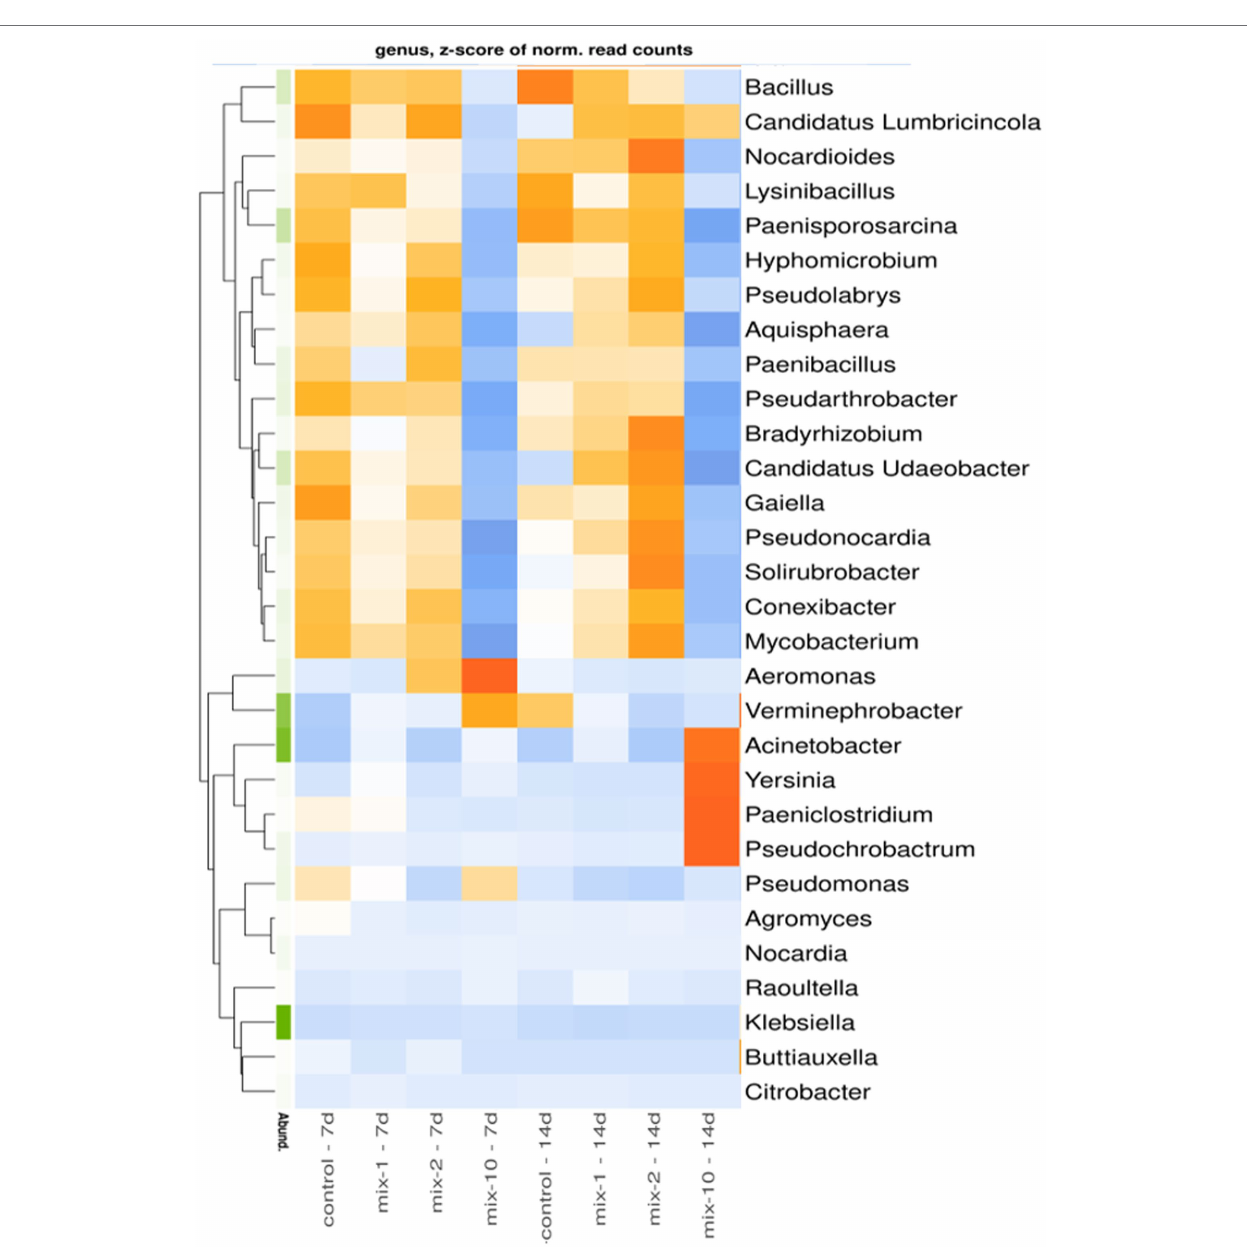
( Figure 5 ). For instance, the Shannon biodiversity index decreased from 3.6 in the control to 2.2 ( p < 0.05) in the variants with a 10-fold application rate ( Figure 5 ). The maximum values